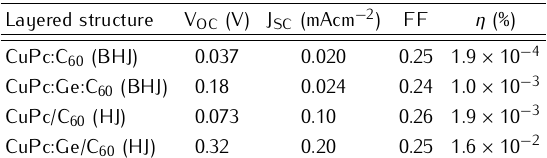
Table 1. Measured parameters of the present bulk heterojunction (BHJ) and heterojunction (HJ) solar cells. Layered